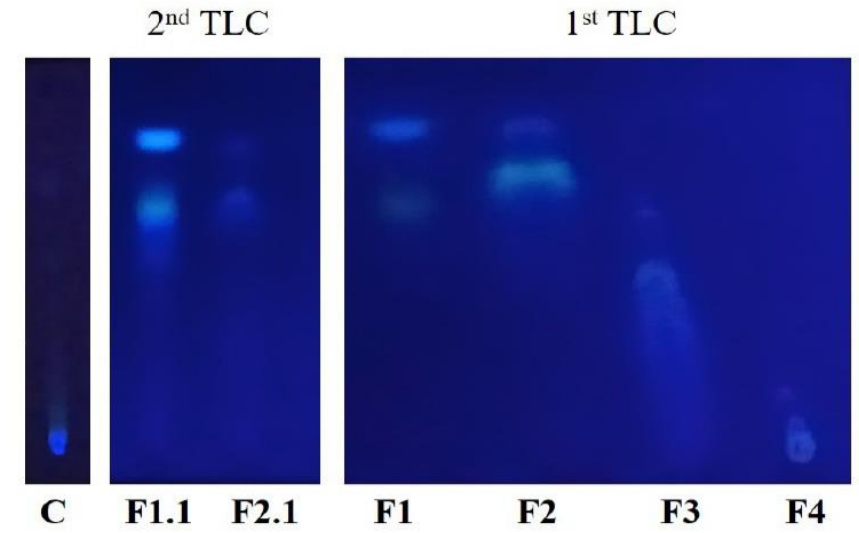
Figure 5. Comparison between the first and the second TLC. Second TLC was made with the two fractions obtained from the second VLC. F1.1 is the fraction obtained with hexane and F2.1 with dichloromethane.